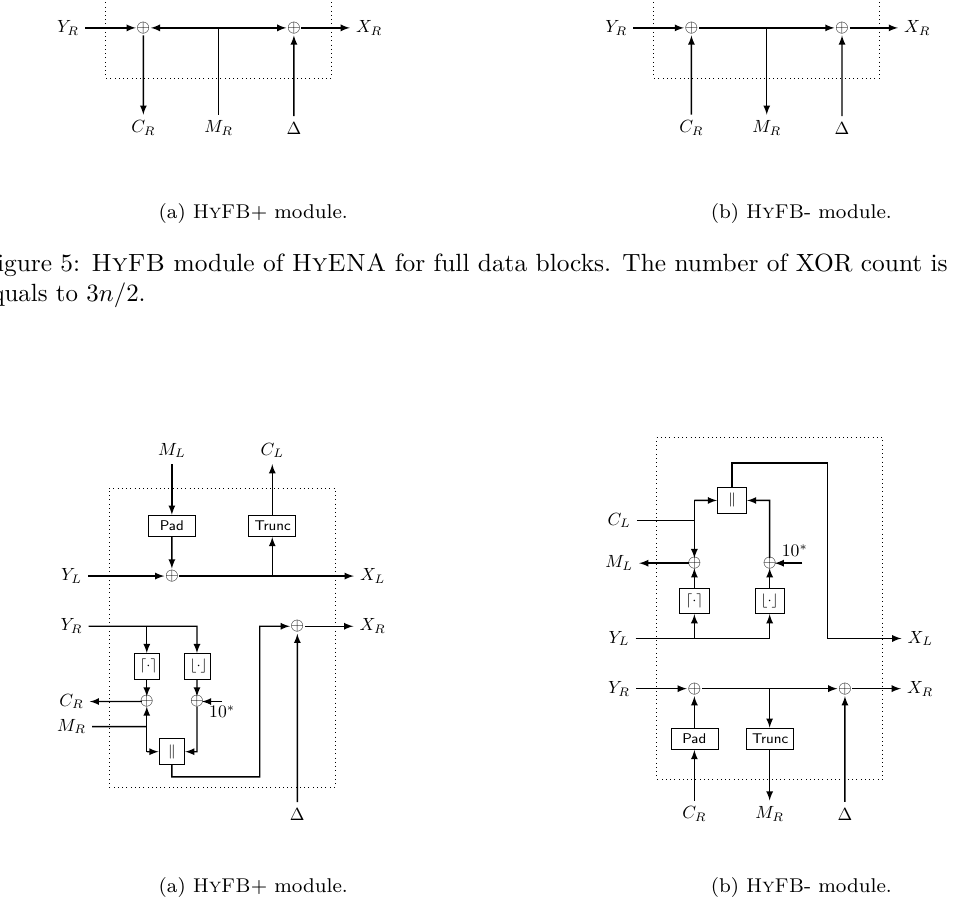
Figure 6: HyFB module of HyENA for partial data blocks. Similar to the full block case, the number of XOR count here also equals to 3 n/